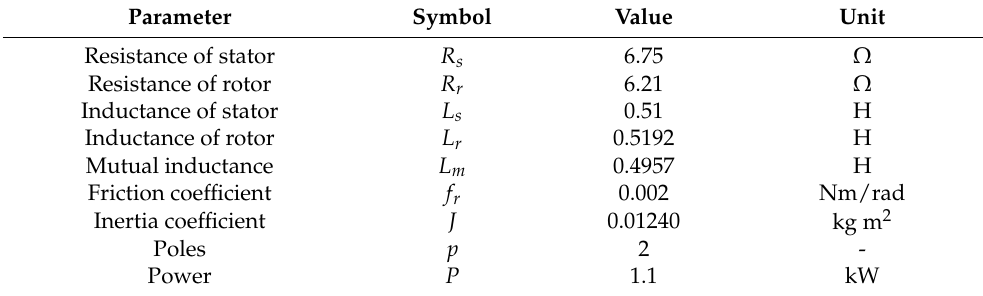
Table 2. Motor parameters